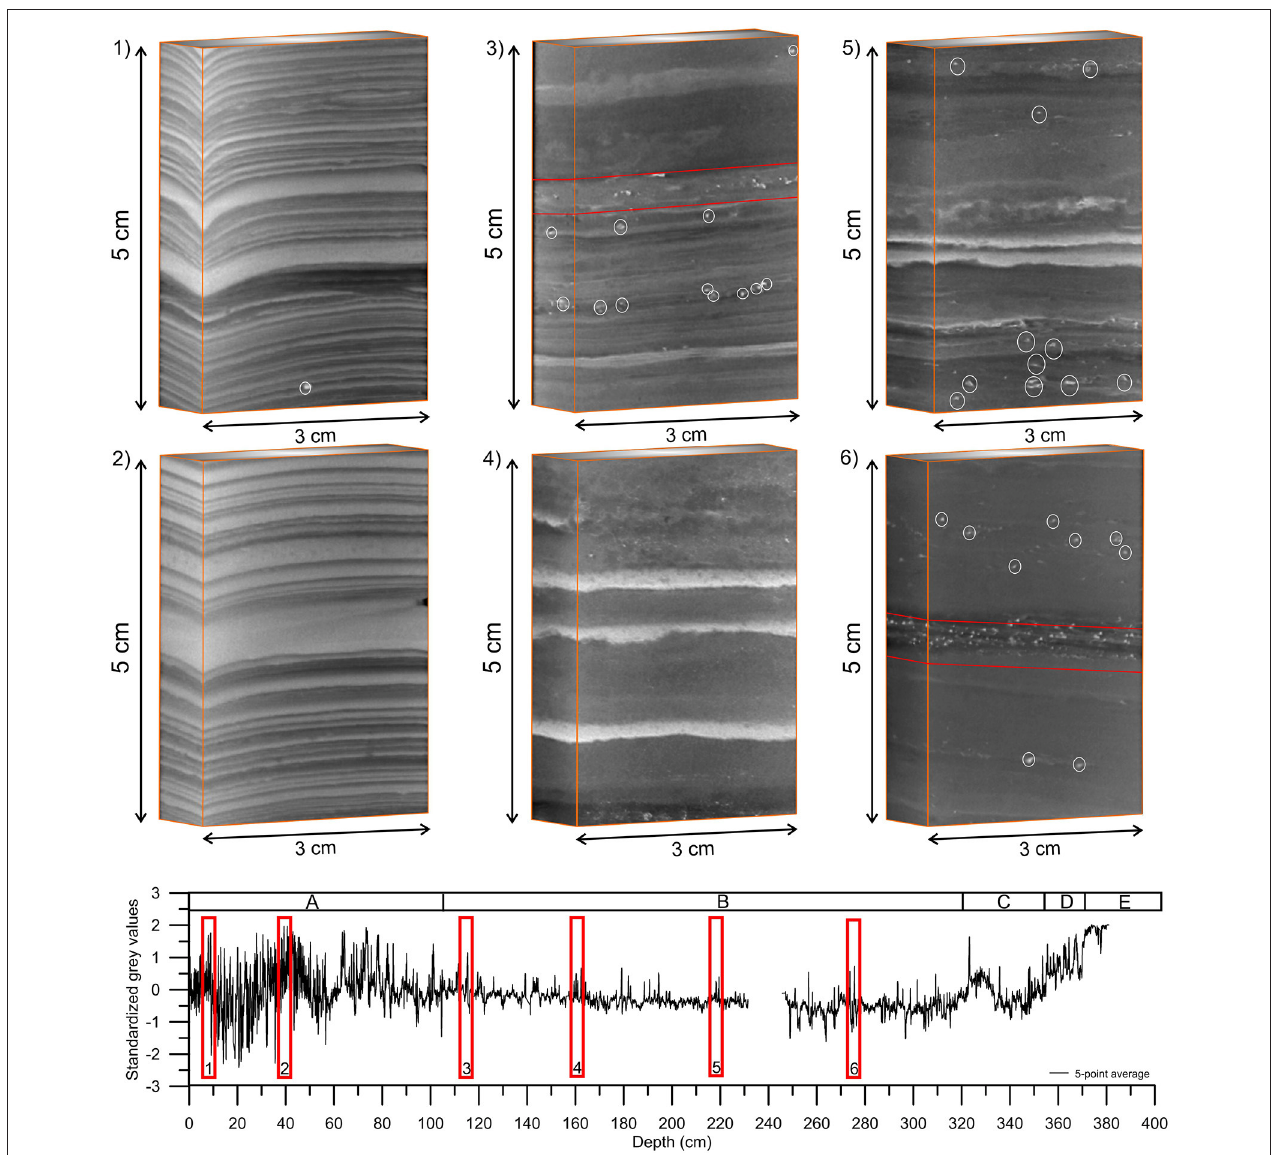
FIGURE 10 | 3D segments (3 × 1.5 × 5cm) from the CT scan at selected intervals (Slice 1: 7–11cm; Slice 2: 37–42cm; Slice 3: 61–66cm; Slice 4: 160–165cm; Slice 5: 215–220cm; Slice 6: 277–282cm). The grayscale values reveal the relative density of the sediments, with the bright color being the densest. The white circles indicate the distribution of isolated grains (sand-sized particles) while the red lines indicate layers of sand-sized particles. These particles were furthermore mapped out and extracted using the software Avizo throughout VAP114 as seen in Figure 9C . Below: The result from the CT scan shown as standardized grayscale values along a probe in the middle of the different core parts of VAP114. The section from 235–247cm is missing due to a lack of data from the X-ray